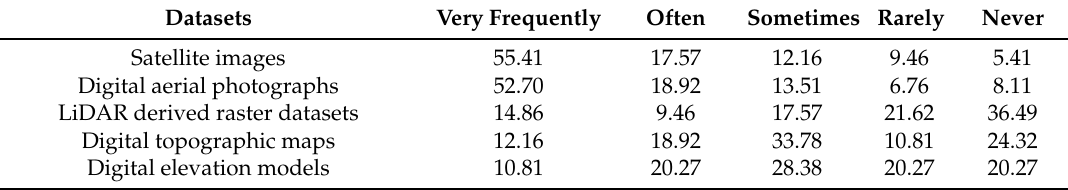
Table 6. Frequency of use (percent of respondents) of raster datasets by recent graduates from forestry programs at Mississippi State University, Oregon State University, and the University of